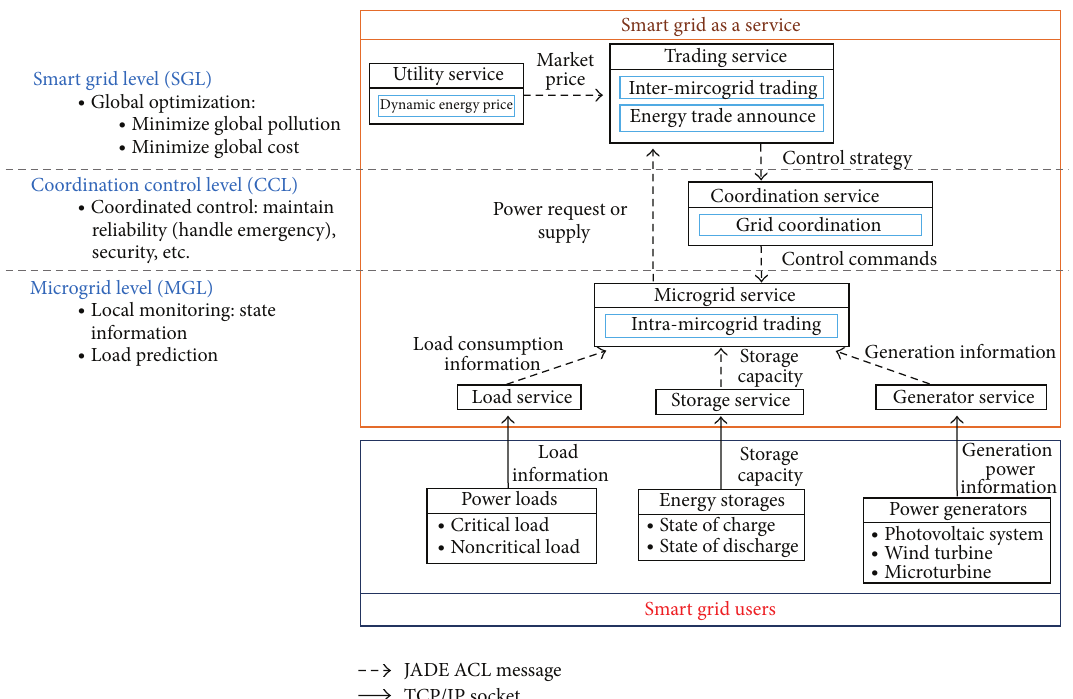
Figure 2: Smart grid as a service